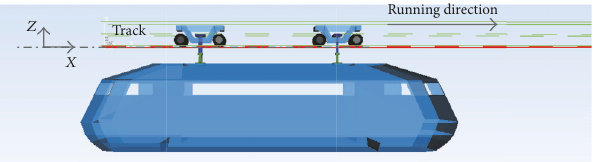
Figure 6: The simulation models for suspended monorail vehicle.